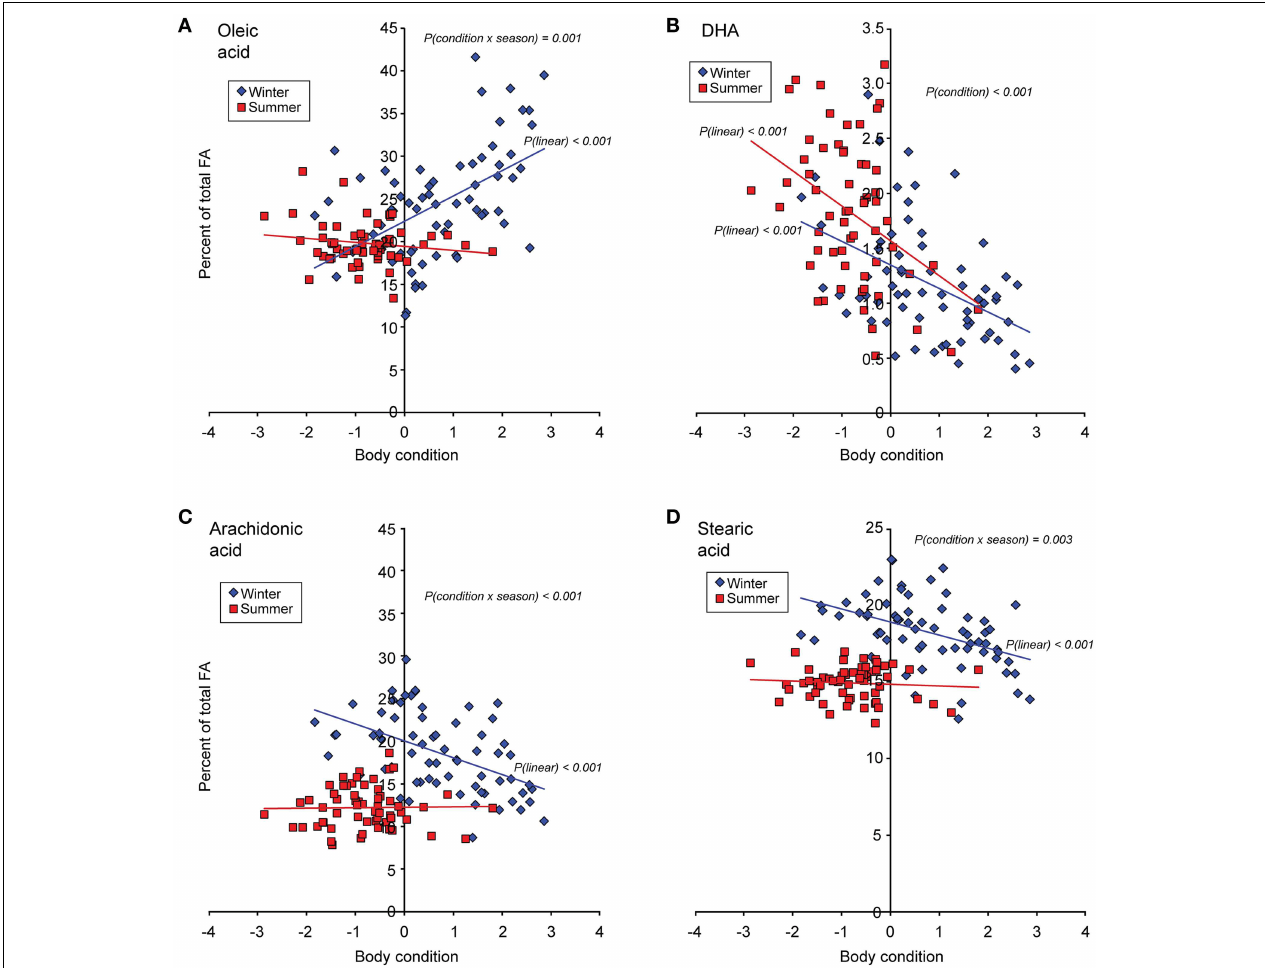
FIGURE 3 | The relationship between body condition (i.e., the residuals from a regression between body mass and tarsus length) and fatty acid (FA) proportions in great tit blood plasma during winter and summer ( N total = 126 ). (A) Oleic acid, (B) docosahexaenoic acid (DHA), (C) arachidonic acid, and (D) stearic acid. Untransformed data are plotted, whereas the statistics